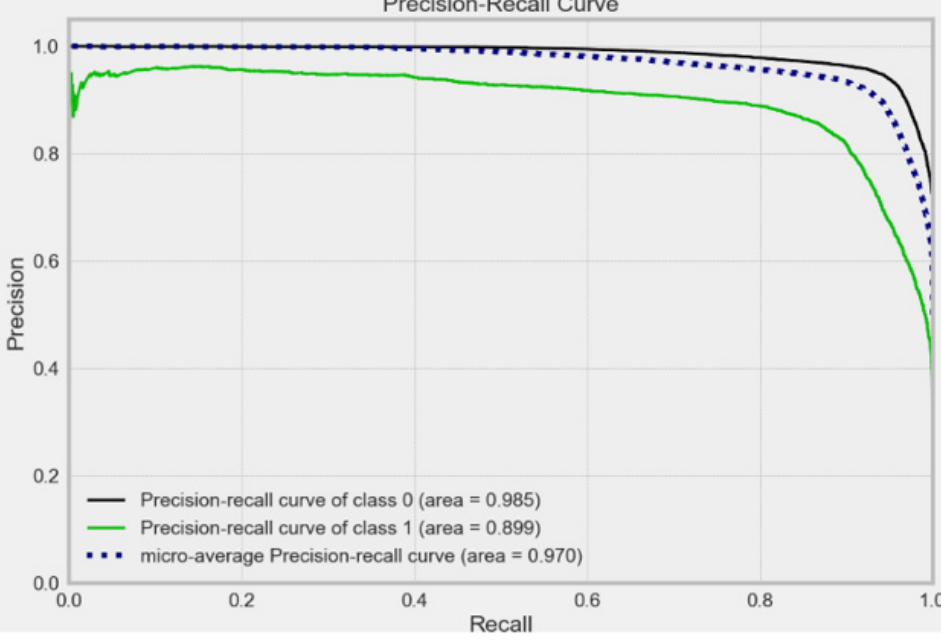
Figure 17. Precision–recall Curve for XGBoost model.